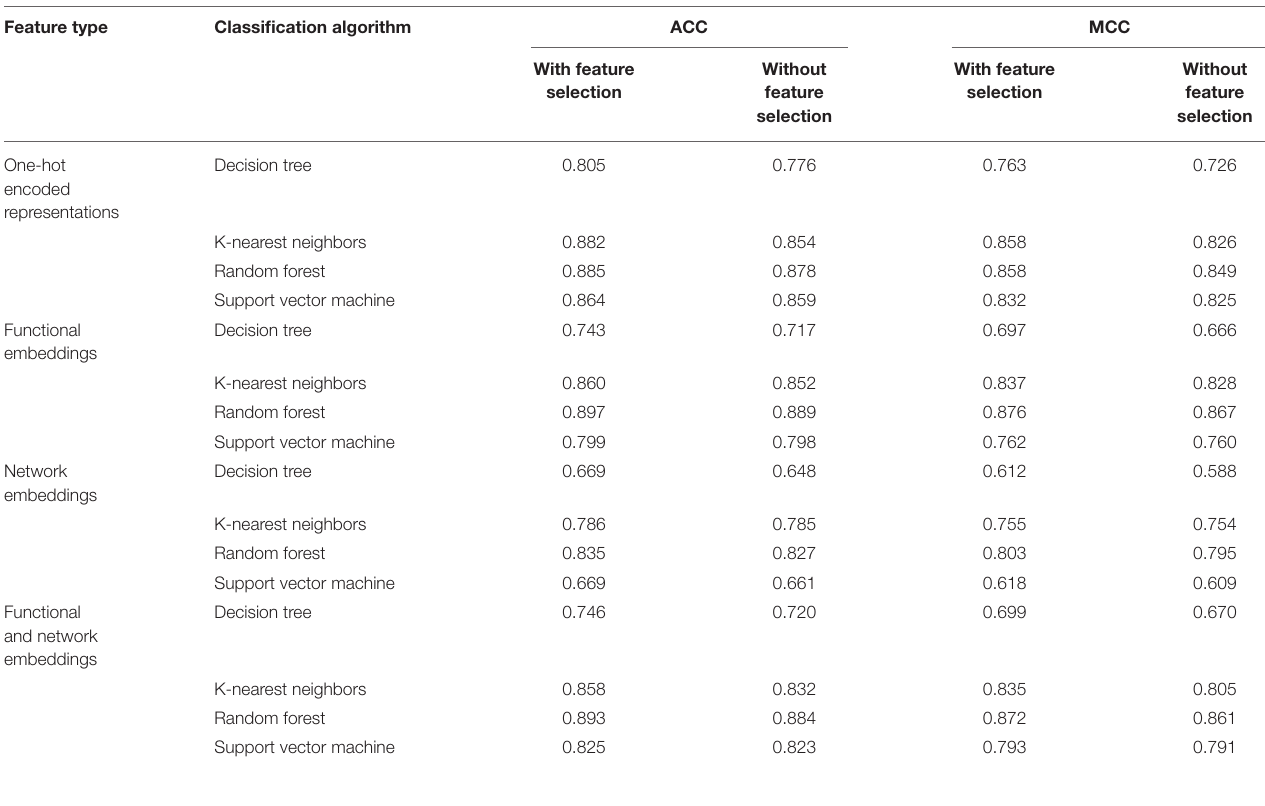
TABLE 2 | Comparisons of different classifiers with or without feature